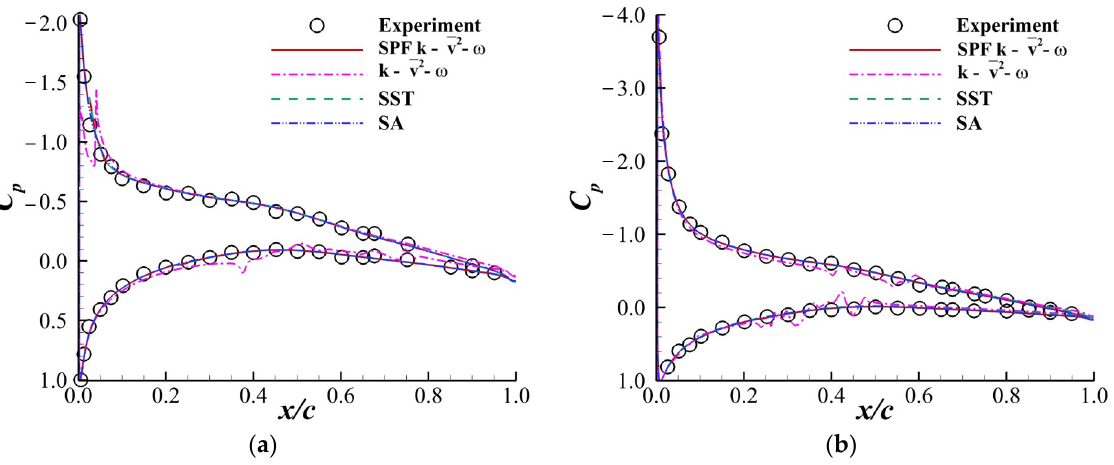
Figure 10. Pressure distributions on the NACA64A010 airfoil when Re = 4.1 × 10 6 and Ma = 0.167. The circles come from the experimental data of Peterson [34]. ( a ) AOA = 4 ◦ . ( b ) AOA = 6 ◦